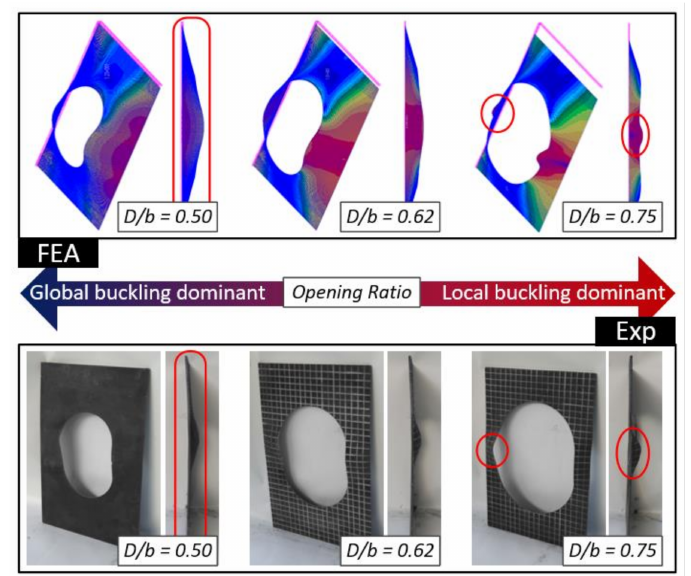
Figure 7. Buckling phenomenon of perforated plates dependent on the opening ratio (a/b = 1.5 and t = 8